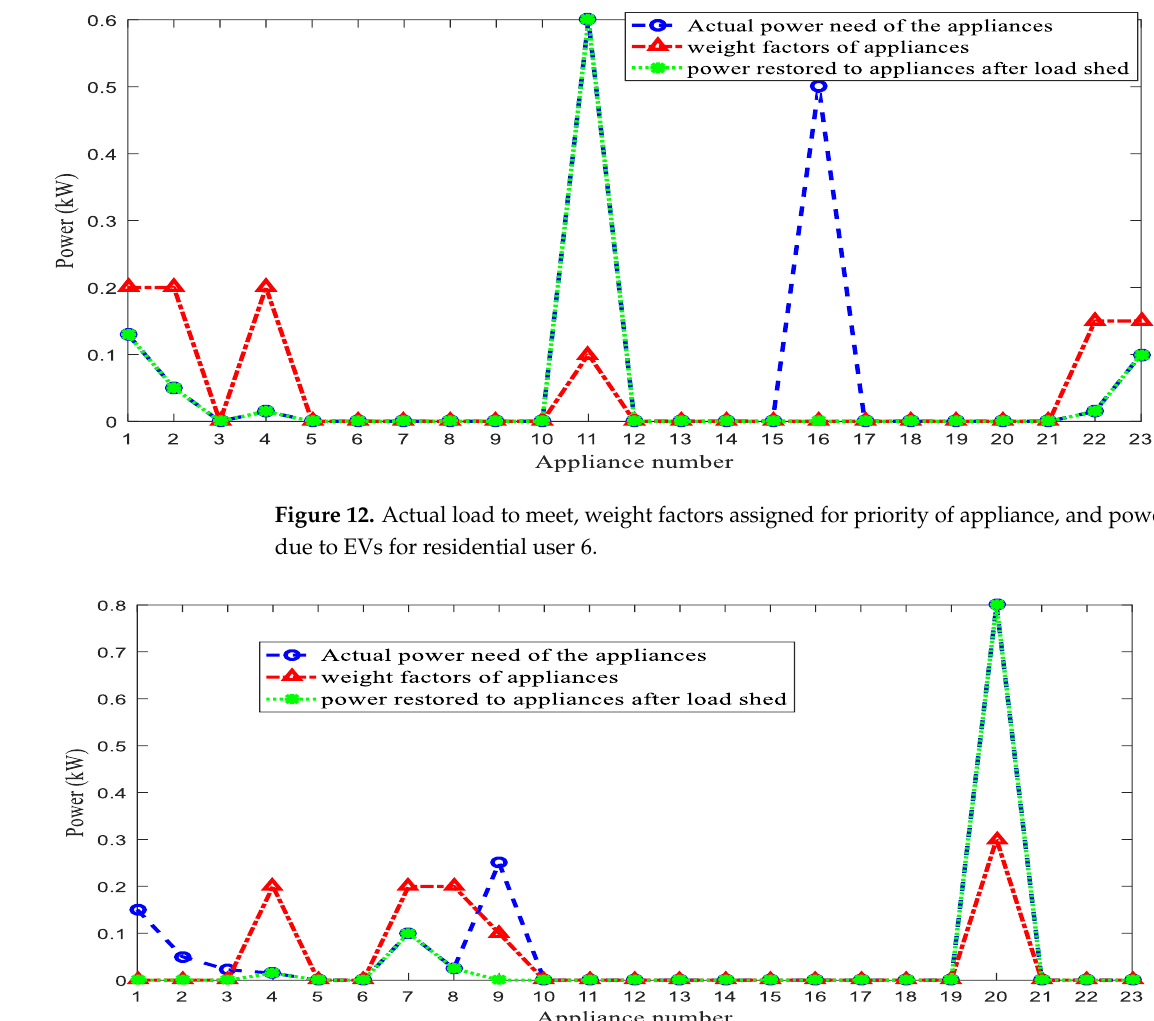
Figure 11. Actual load to meet, weight factors assigned for priority of appliance, and power re- stored due to EVs for residential user 5.